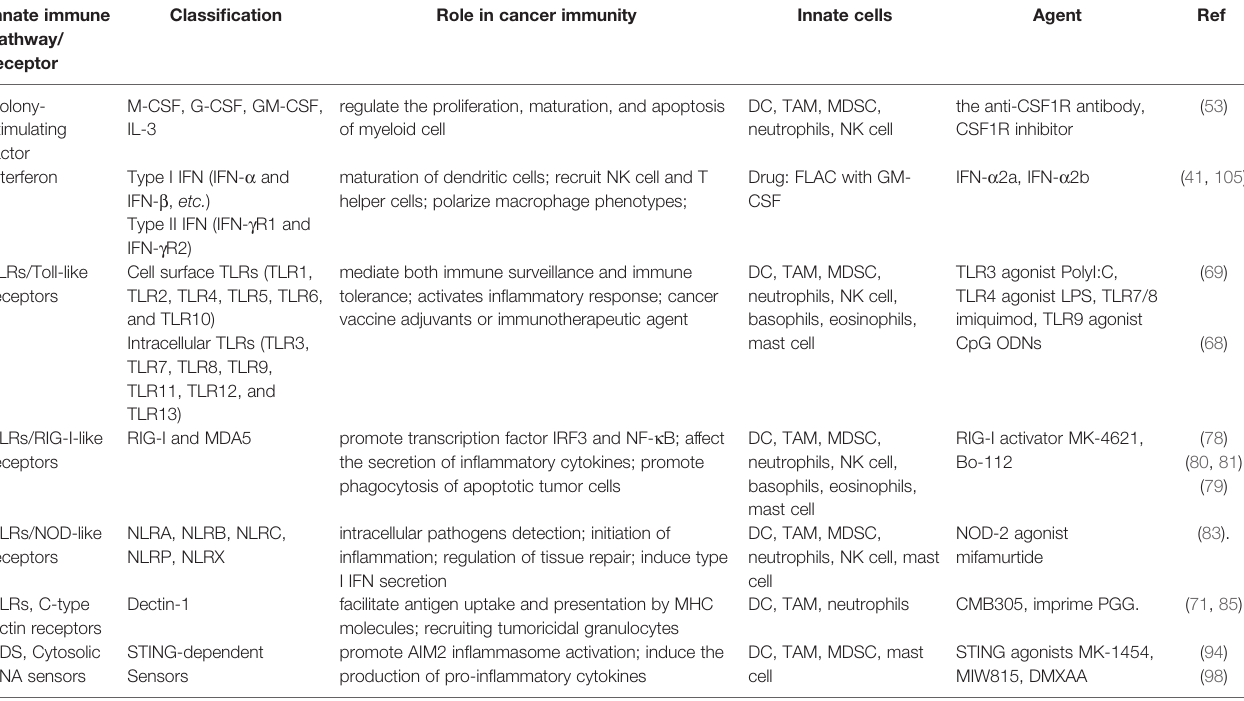
TABLE 1 | Factors and mechanisms related to anticancer innate immunity and summary of agents in the use of breast cancer immunotherapy. Innate immune